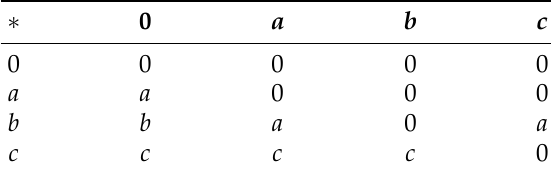
Table 5. Cayley table for the binary operation “ ∗